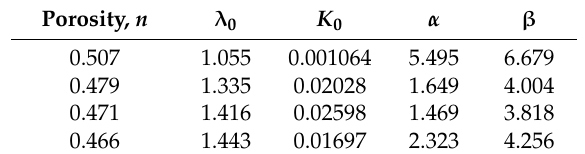
Table 3. The Fitting Parameter Results using Equation (15).